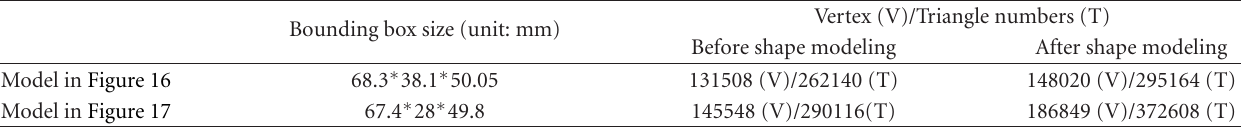
Table 1: The detailed information of the 3D dental models.